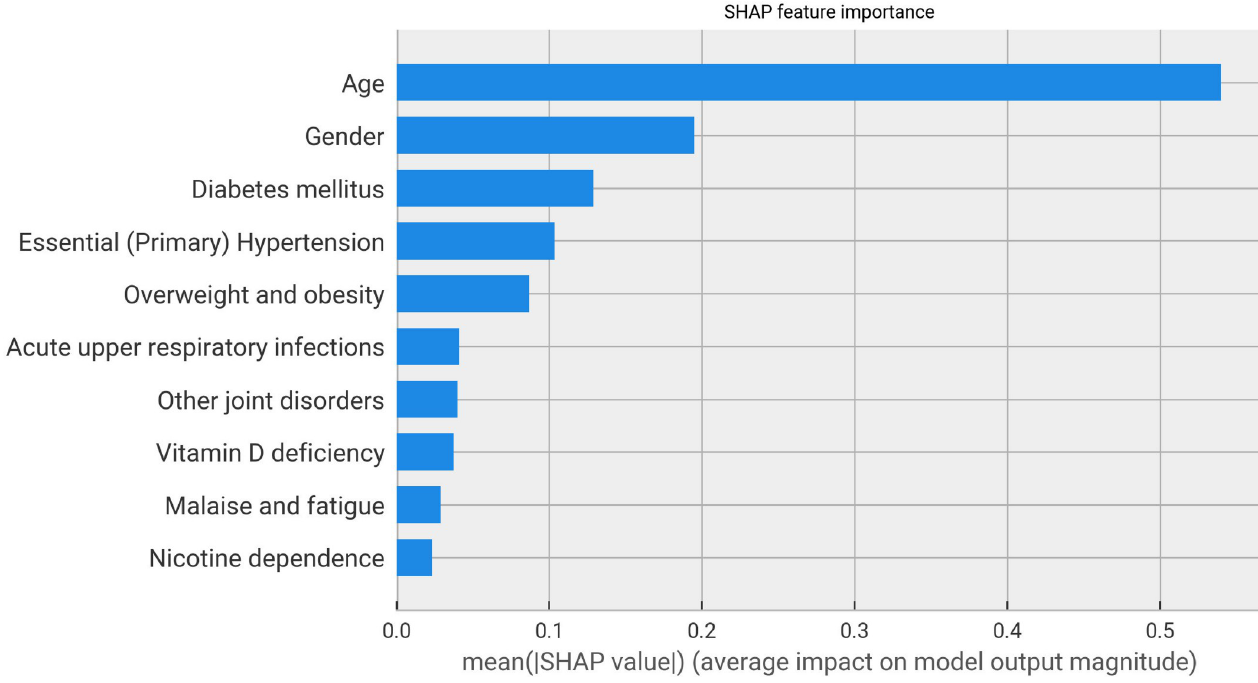
Fig 5. Most important predictive features. Top 10 features with highest absolute SHAP values.